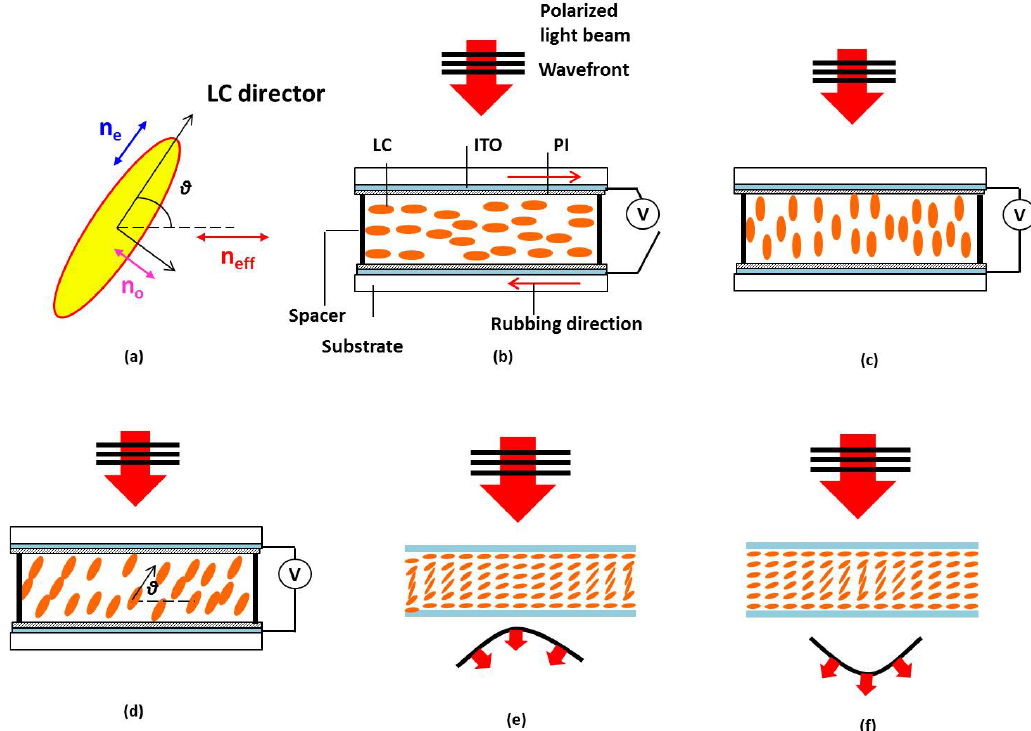
Figure 1. Operation principle of a nematic LC lens: ( a ) LC molecular and polarization dependent refractive index; ( b ) schematic structure of a homogeneous LC cell, the incident light sees n ; ( c ) LC directors are reoriented along the electric field and the incident light e sees n ; ( d ) LC directors are reoriented by a θ angle and the incident light sees n o ( e ) positive LC lens, and ( f ) negative LC